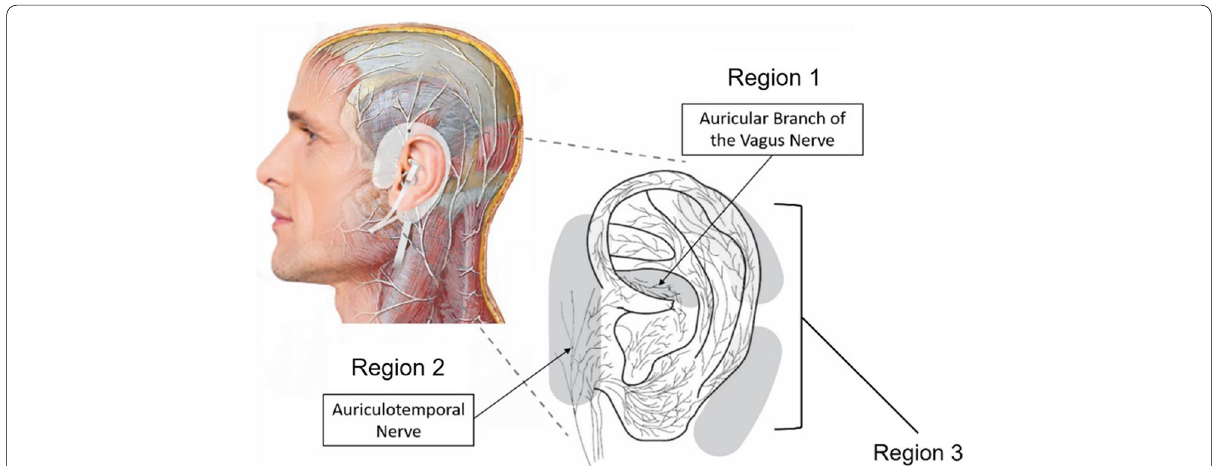
Fig. 2 Form and Fit of tAN Device Around the Ear Neural